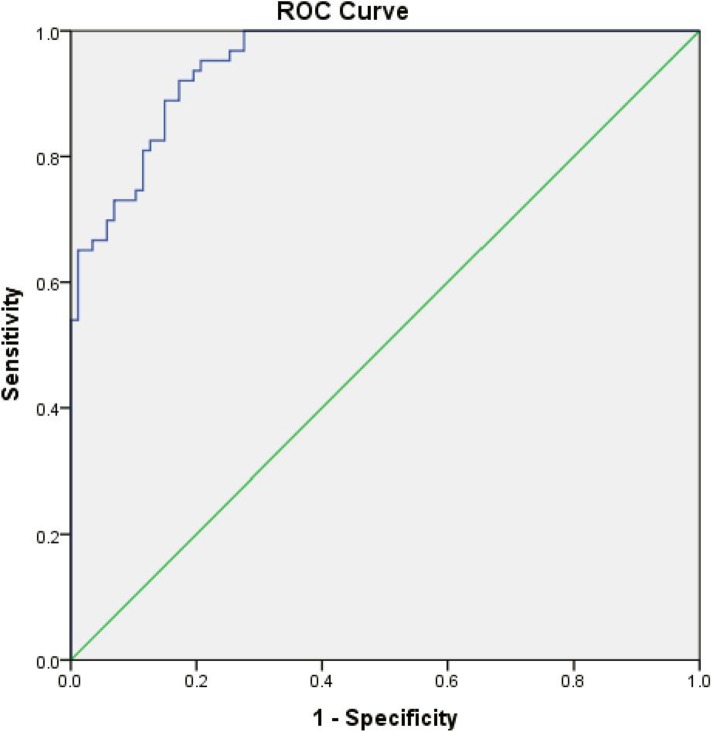
Receiver operating characteristic (ROC) curve for Ln-PCR for the detection of Leishmania parasites in clinical samples.